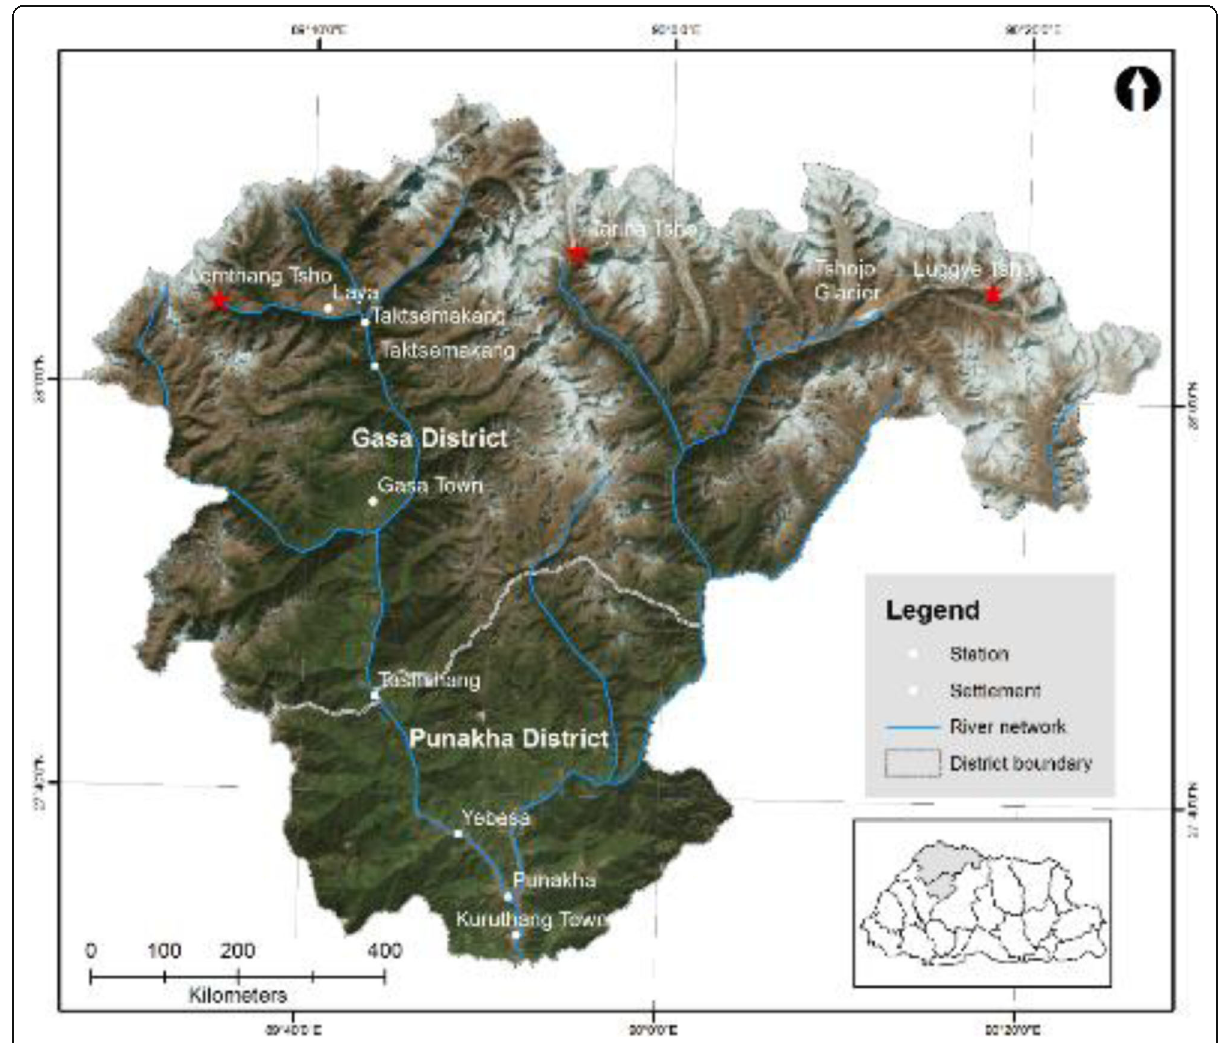
Fig. 7 Map of Gasa and Punakha districts showing locations of settlements and